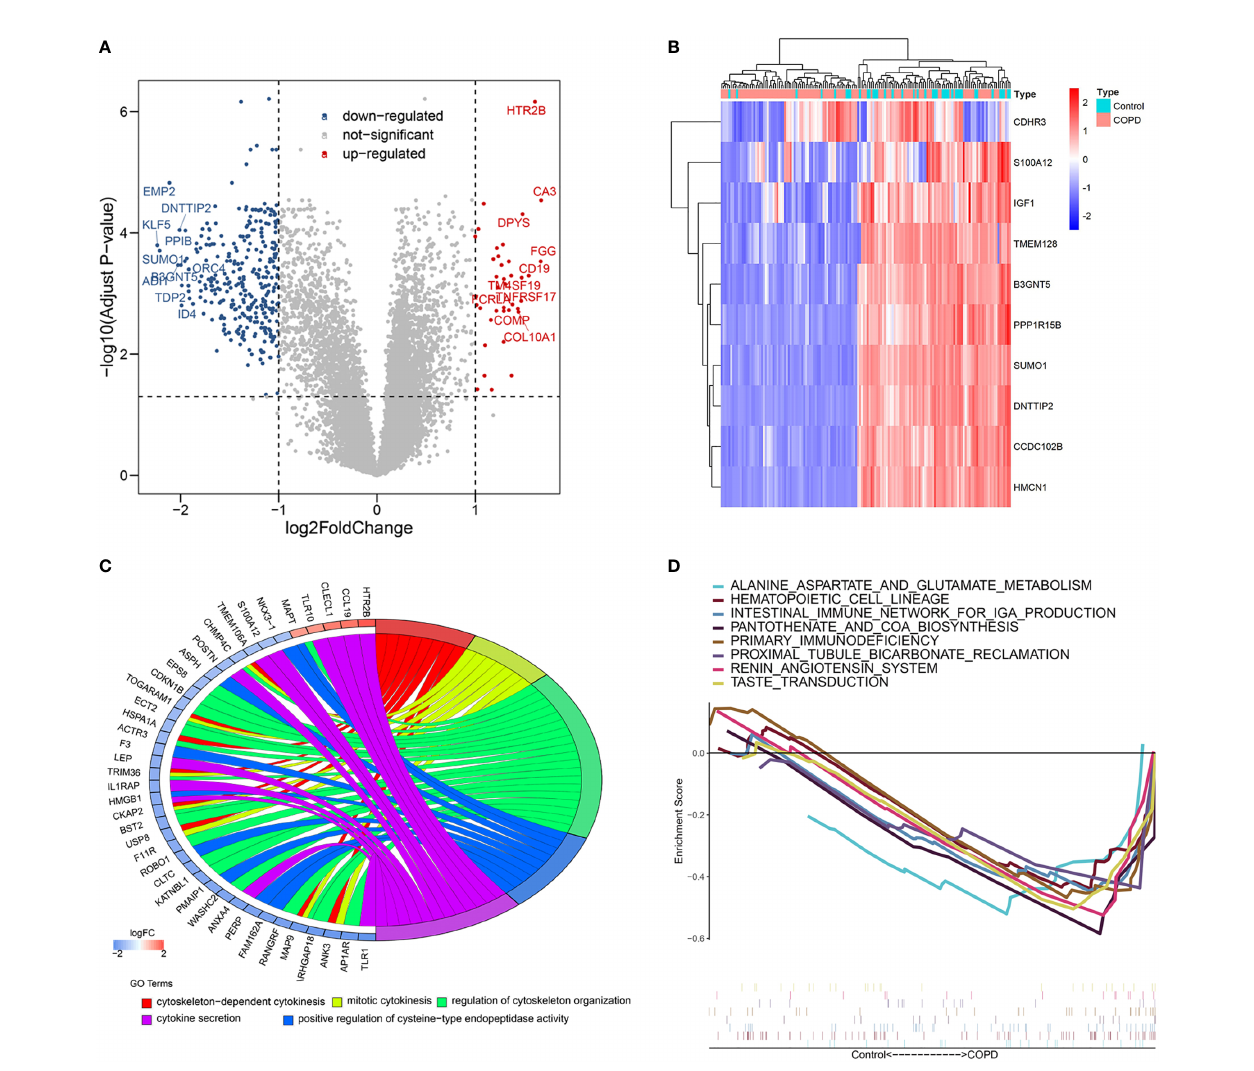
FIGURE 1 | Differential expressed genes analysis and Volcano map (A) and heatmap (B) of differential expressed genes; (C) Chord plot depicting the relationship between genes and Gene ontology (GO) terms of biological process; (D) GSEA showed eight pathways enriched in COPD